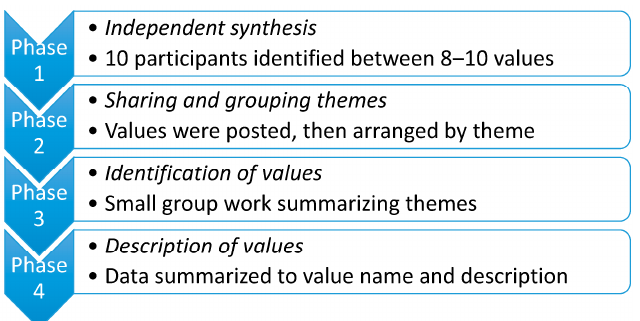
Figure 1. Four phases of the consensus process